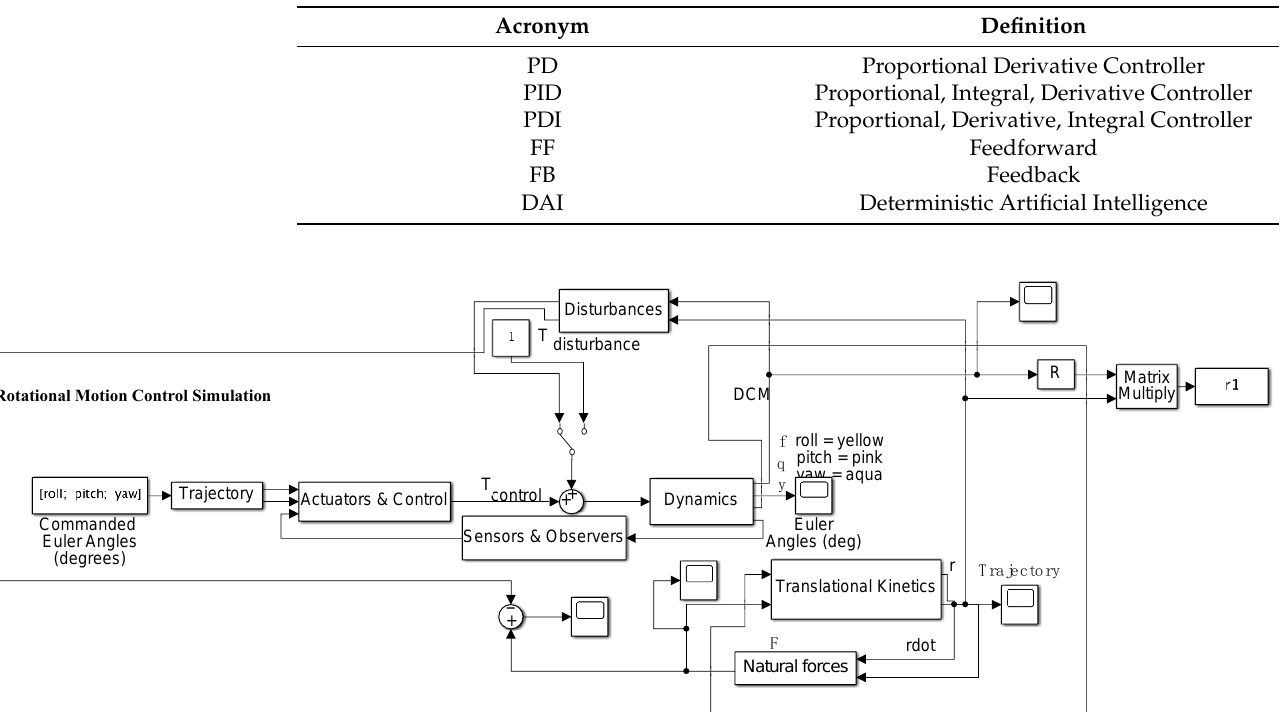
Table A3. Consolidated table of acronyms.